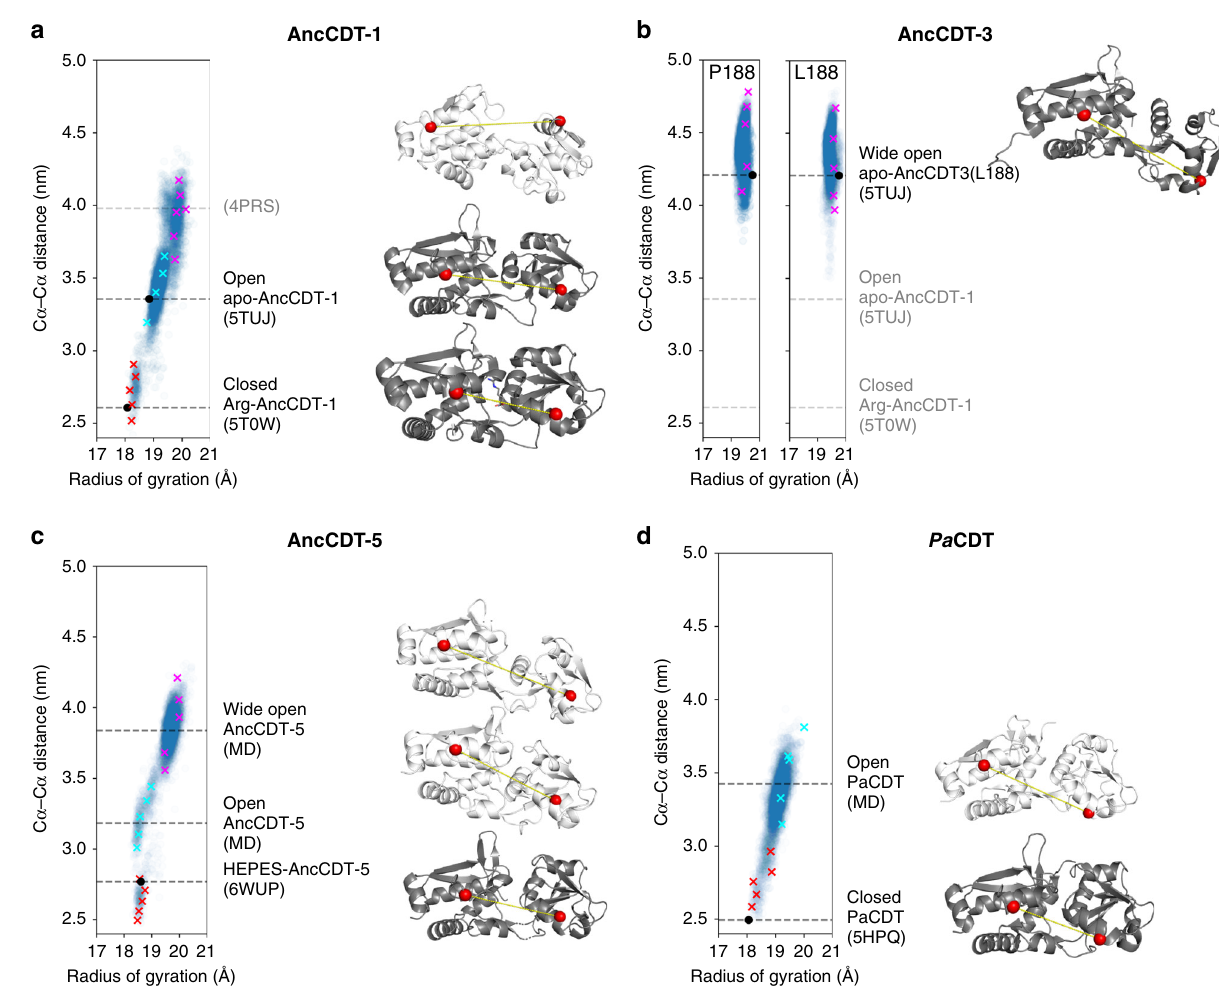
Fig. 4 Conformational substates captured by MD and crystallography. Conformational substates of ( a ) AncCDT-1, ( b ) AncCDT-3, ( c ) AncCDT-5 and ( d ) Pa CDT captured by MD and X-ray crystallography. The plot of C α – C α distances between tagged residues vs. radius of gyration obtained from MD simulation snapshots highlights populations (or lack thereof) of closed, open and wide-open conformational states. Each data point represents a single frame of the MD simulation (sampled every 0.1 ns). Crosses represent snapshots of closed (red), open (cyan) and wide-open (magenta) states that were used to model Gd(III) – Gd(III) distances. Representative structures of each of these states are shown on the right and highlight the extent of the open/ closed transition, with distances between C α s (red spheres) of tagged sites shown by yellow lines. Dark grey structures are crystal structures (corresponding to black dots on the plot), while white structures are MD snapshots. The time evolution of C α – C α distances are shown in Supplementary Fig.